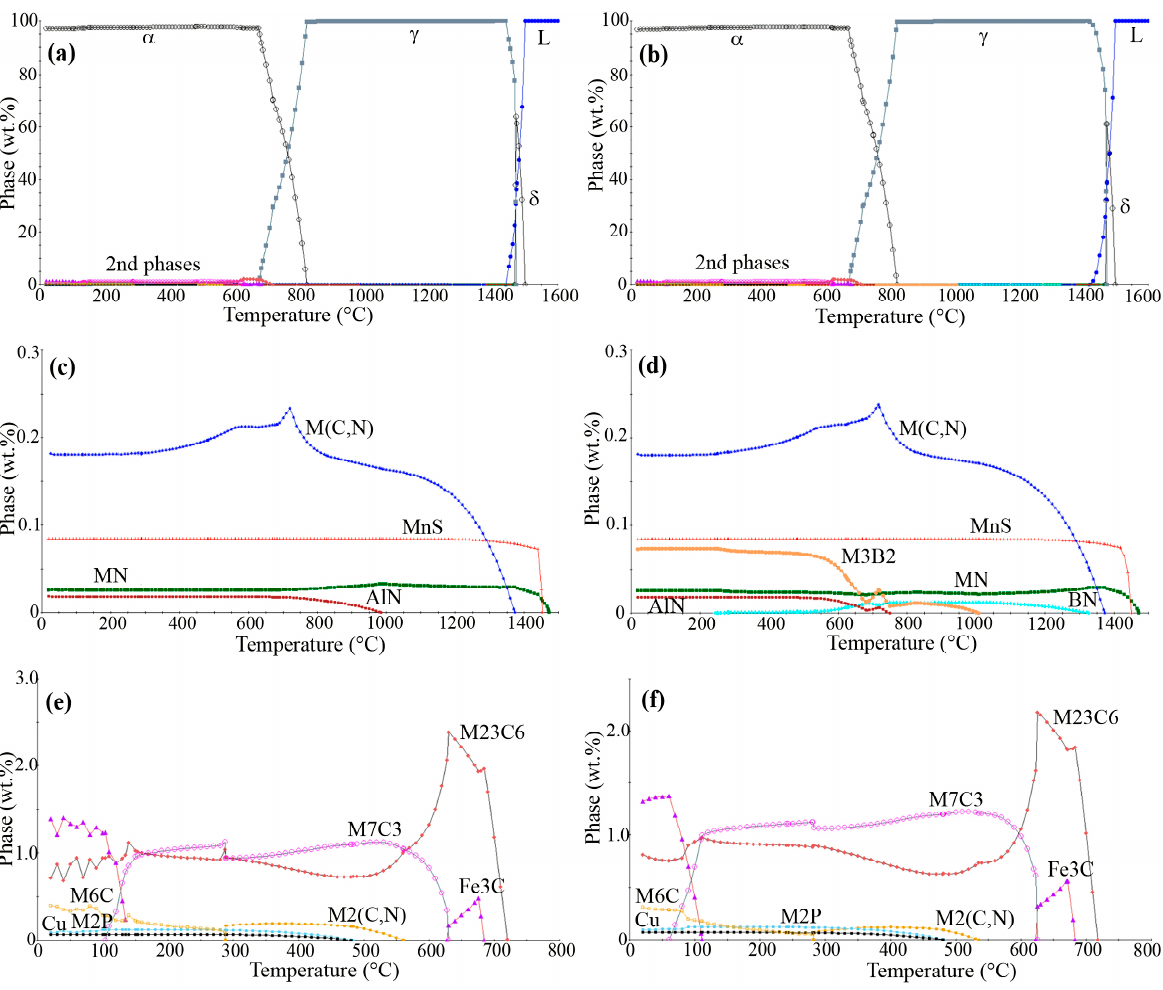
Figure 3. Weight percentage of the phases formed in the complex phase steel: ( a , c , e ) reference boron-free (CP-B0) steel, and ( b , d , f ) boron-containing (CP-B60) steel.